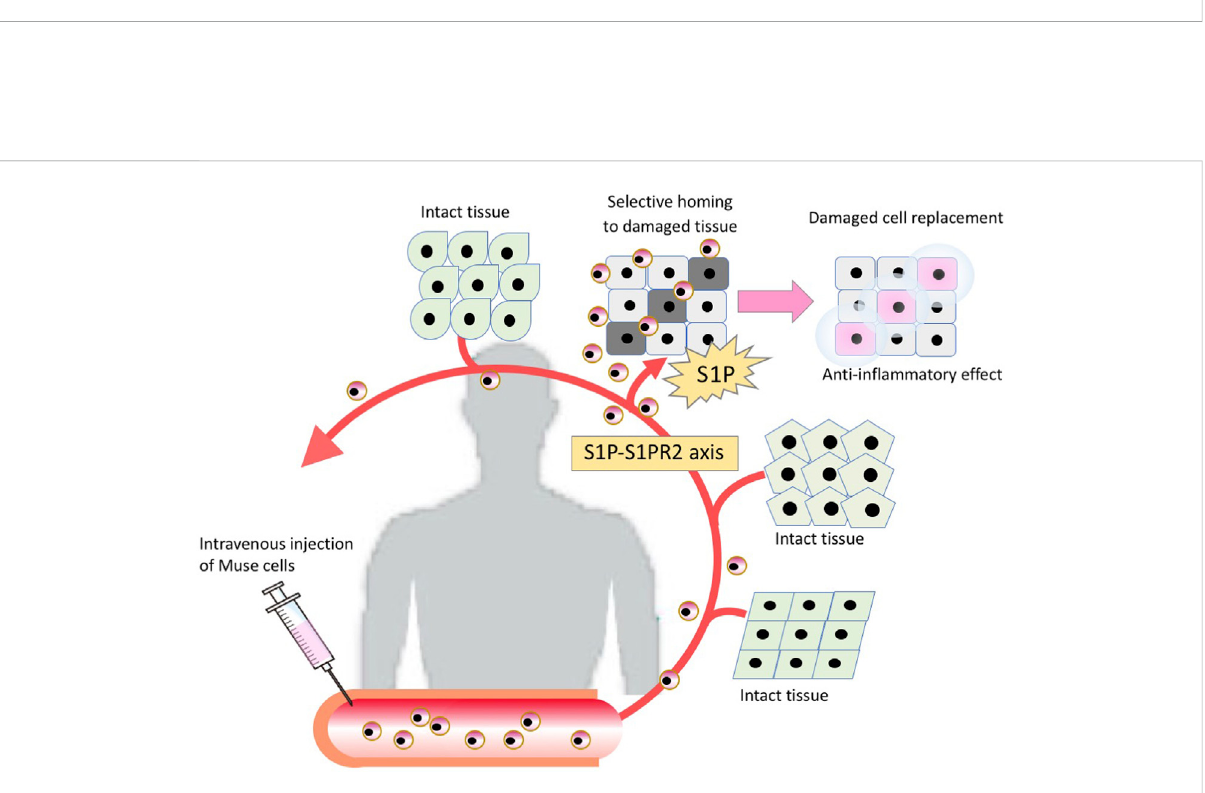
The mechanism of tissue repair by intravenously injected Muse cells. Intravenously injected Muse cells sense the damaged site by the S1P- S1PR2 axis, home to the damaged site and replace damaged cells by spontaneous differentiation into tissue-appropriate cells to repair the tissue.